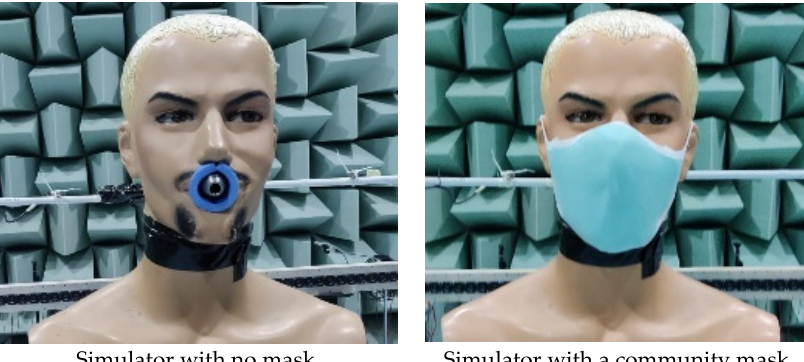
Figure 1. Experimental set-up with the microphone arrangement around the head and torso simu- lator housing the sound source nose in the mouth.